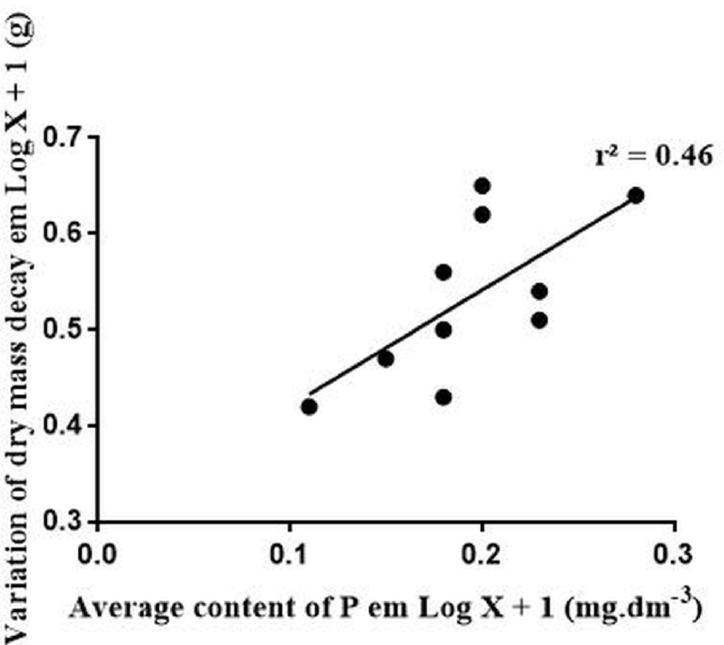
Figure 2. Simple linear regression between total average of P in soil and total variation of dry mass decay in litter-bags considering the 120 evaluation days in the “sandstone cerrado” (F 1,8 = 6.87, df = 8, p =